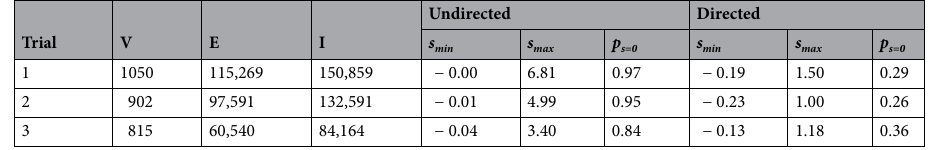
Table 2. Trophallaxis network properties. For each trial we show the number of nodes (V), edges (E), and trophallaxis interactions (I), the smallest spreading speedup (s min ), the biggest spreading speedup (s max ), and the mean prevalence when the speedup of spreading is zero (p s=0 ) for the undirected and the directed spreading simulations. In the case of directed spreading, s min , s max , and p s=0 were computed with respect to the temporally and directionally randomized reference